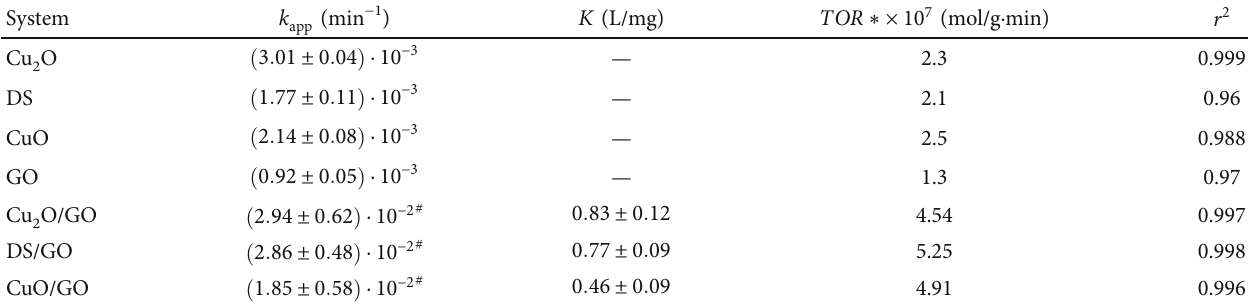
Table 2: Calculated rate constants for all studied systems.